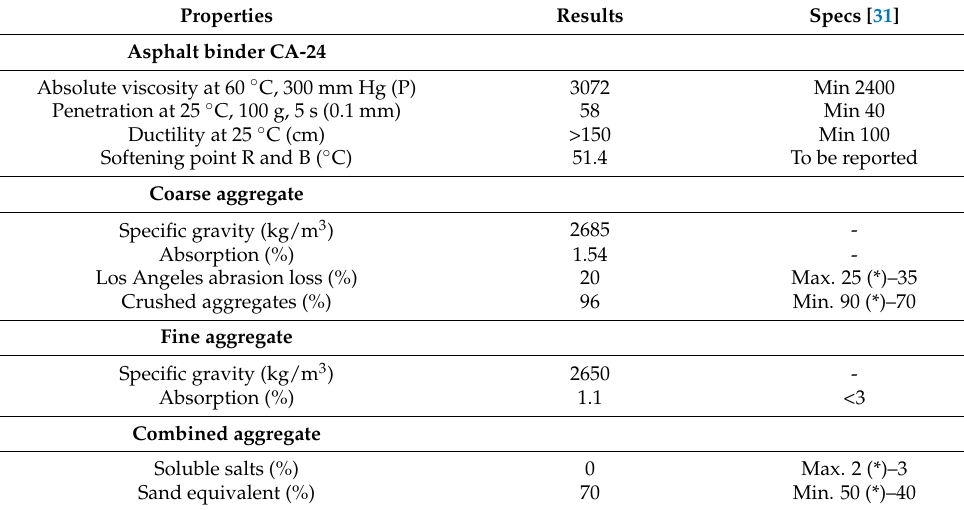
Table 2. Properties of the asphalt binder and aggregates used in the tests.